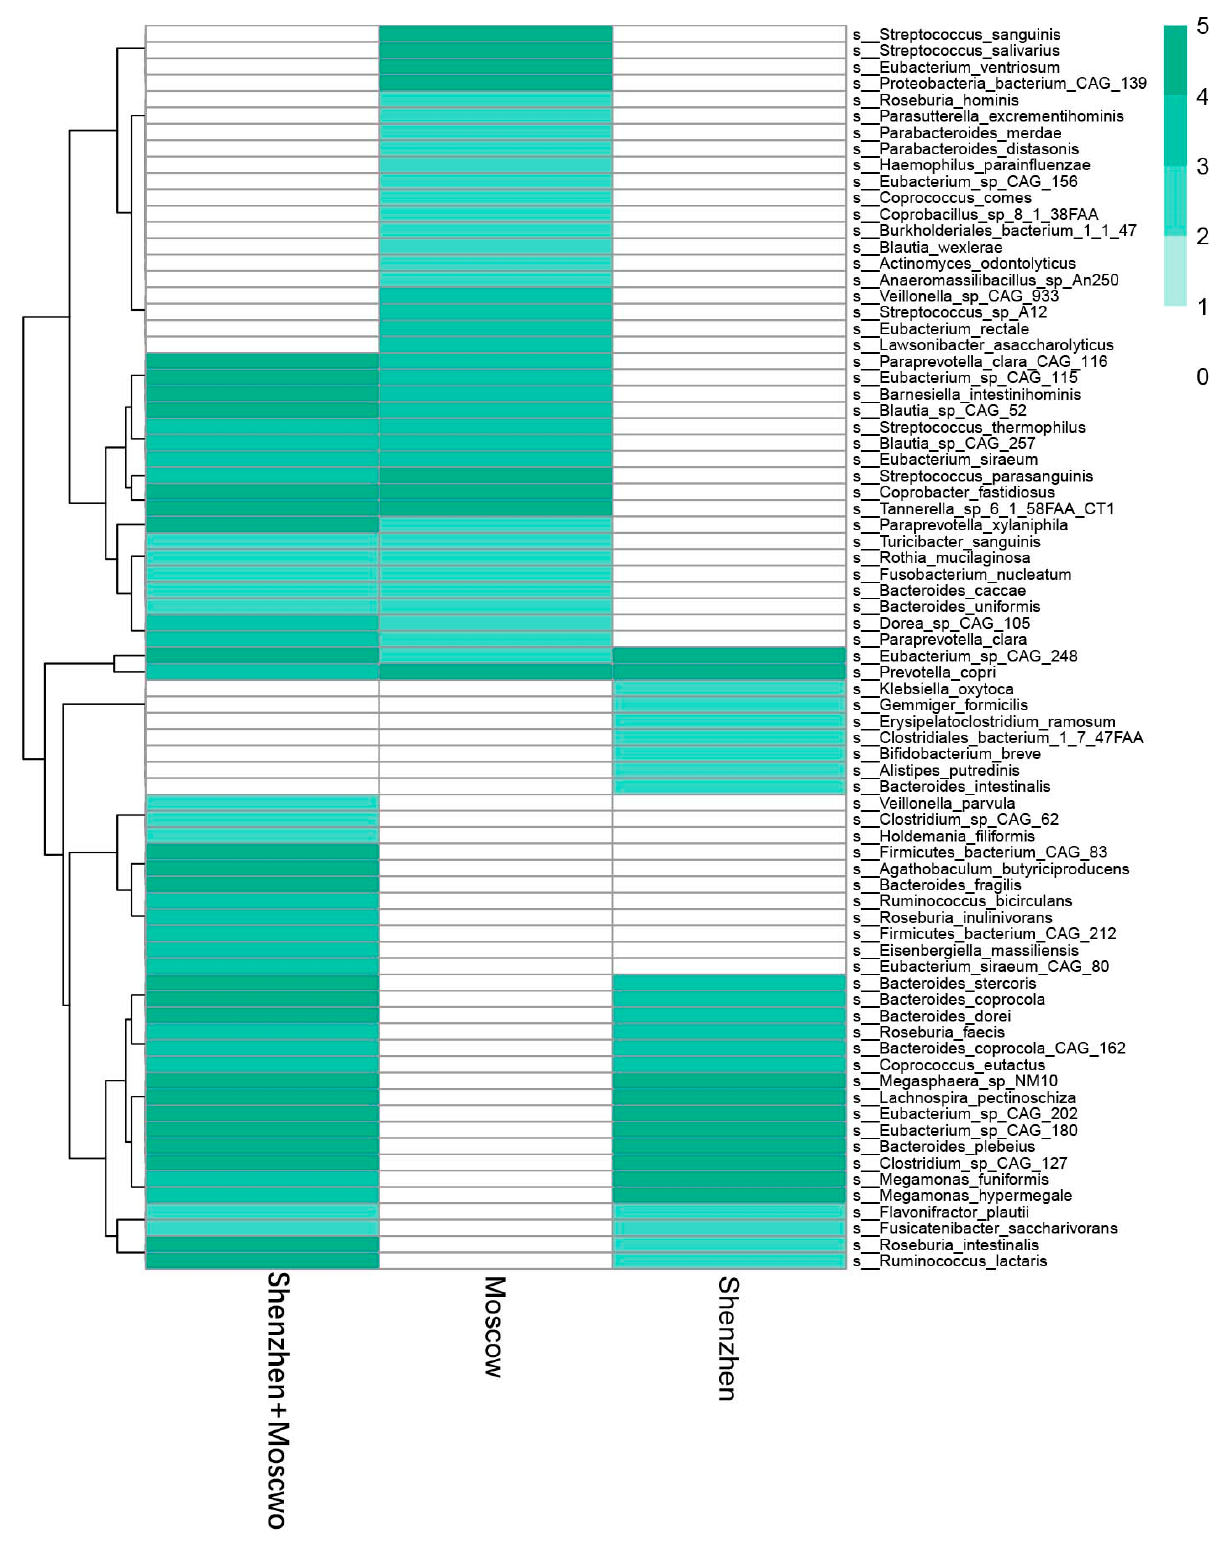
Figure 7. Potential biomarkers. Only Eubacterium_sp_CAG_248 and Prevotella copri species were present across the Moscow cohort, the Shenzhen cohort, and both cohorts combined; they were considered the potential biomarkers.